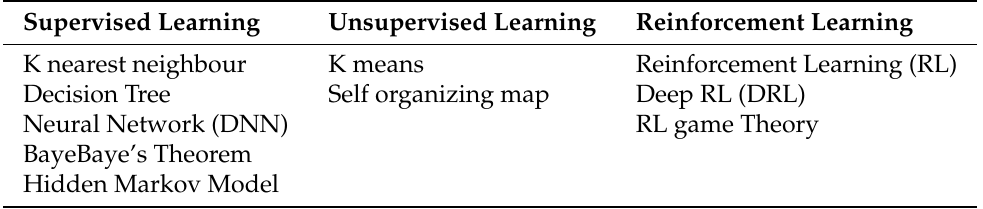
Table 5. Machine learning algorithms applied to SDN